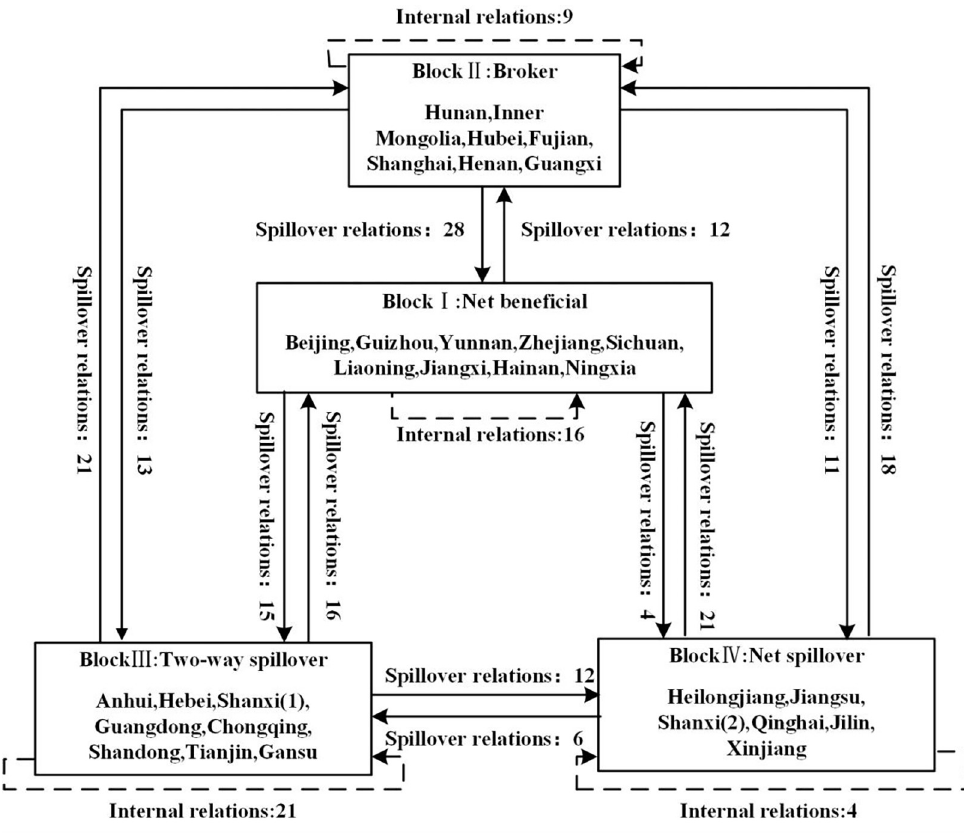
Fig 1. Four blocks and their spillover